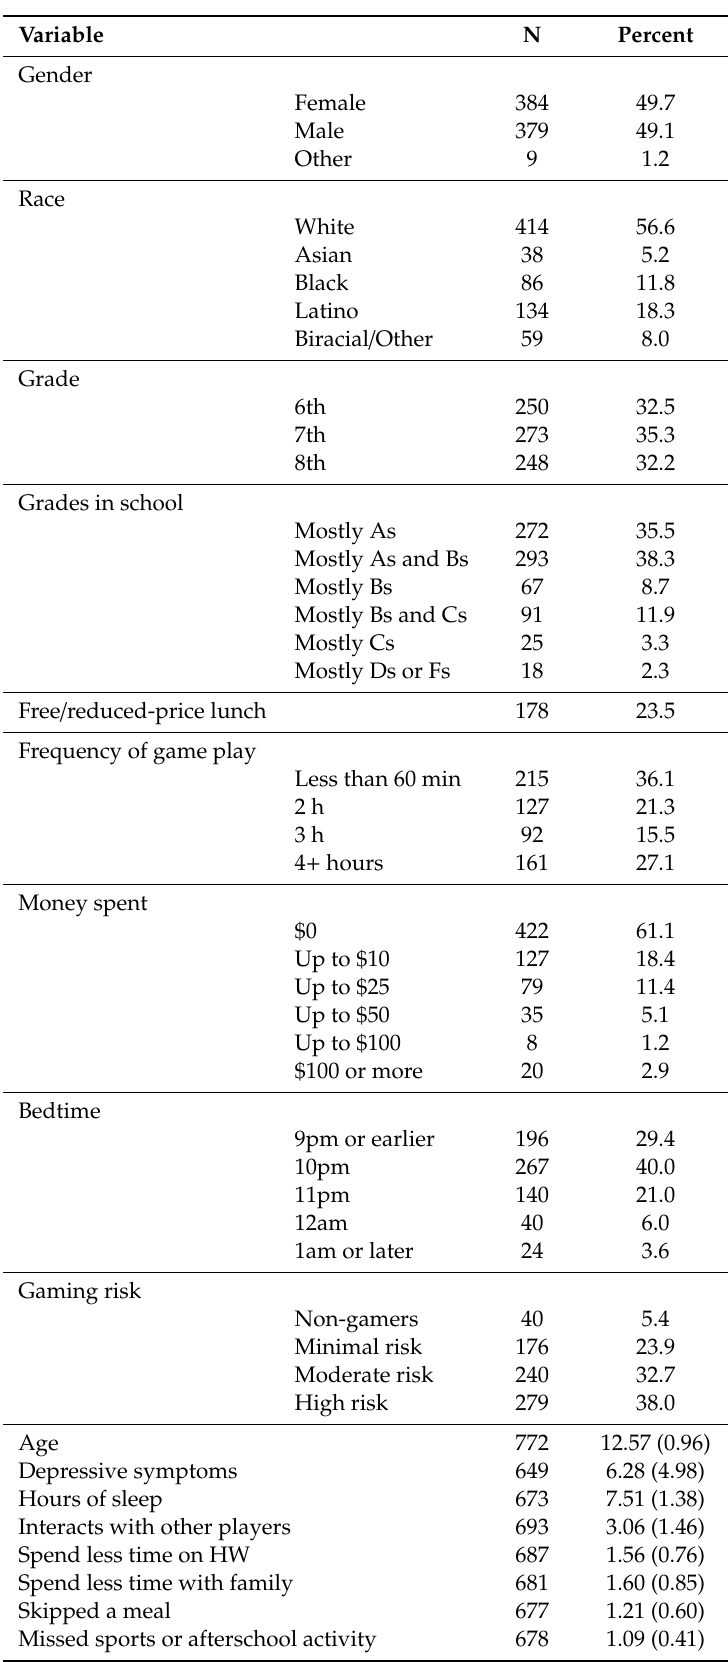
Table 3. Study 2: Sample